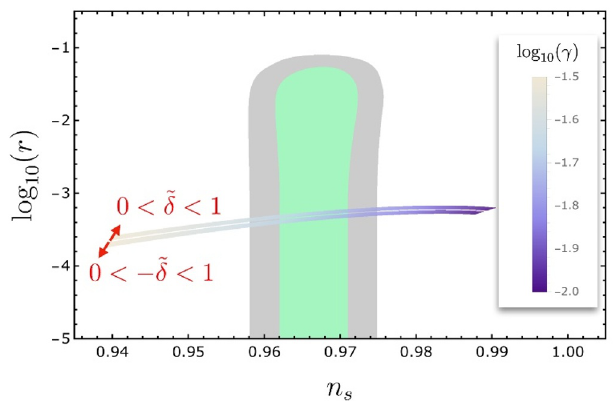
Figure 5 . Same as figure 2 but now we compare the Planck contours with the analytical predictions for n ( δ ) s and r ( δ ) and log ( γ ) ∈ [ − 2 . 0 , − 1 . 5] , where we vary log ( | ˜ δ | ) ∈ [ − 2 . 0 , − 1 . 0] while fixing 10 10 α = 0 . 01 . The region ˜ δ > 0 corresponds to inflationary trajectories with wide initial condition range of the type shown in figure 6 ending up in the false minimum at φ 1 = 2 π/c 1 , φ 2 = −O (˜ δ ) .The com- plement ˜ δ < 0 corresponds to trajectories which in figure 6 start with φ 2 -values beyond the saddle point with little allowed initial condition space, and end up in the true minimum at φ 1 = φ 2 = 0